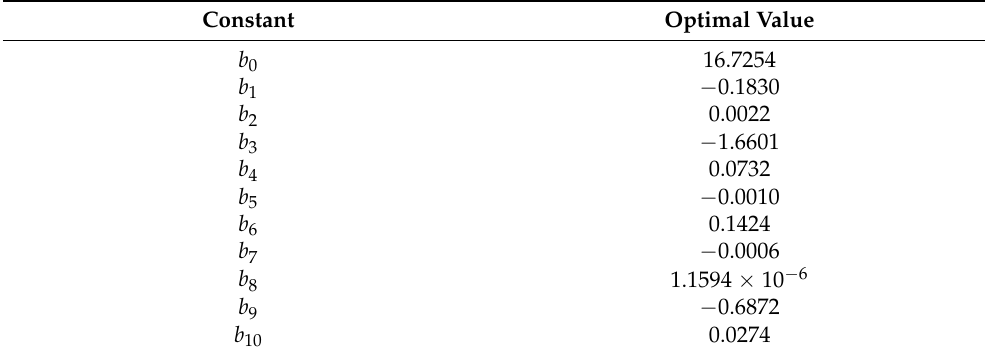
Table 6. The optimal values of the nickel rejection model fitting